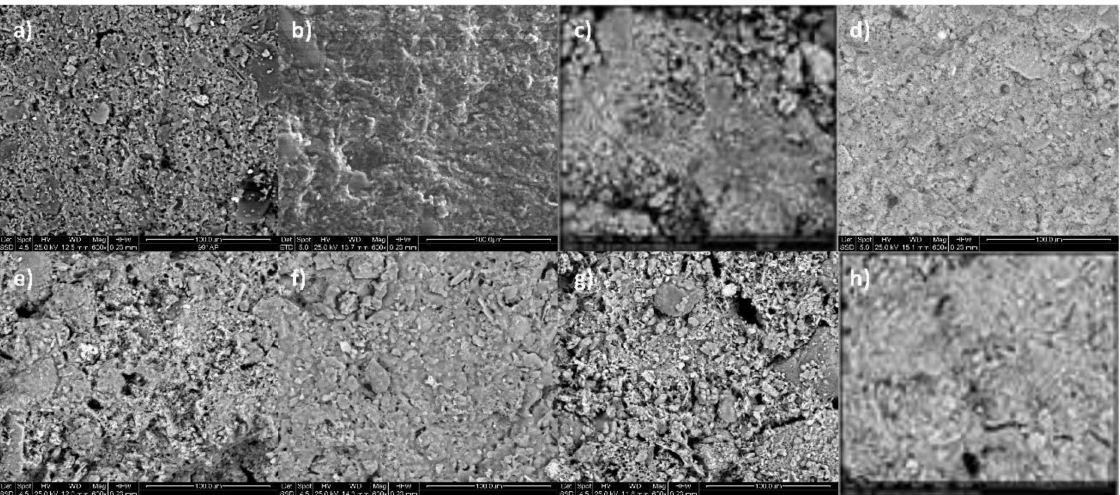
Figure 3. LWAs—SEM micrographs (600 × ) of ( a ) WBC, ( b ) RC, ( c ) WBBS 15 , ( d ) RCBS 15 , ( e ) WB FG , ( f ) RC FG , ( g ) WB CBA , and ( h ) RC CBA fired at 1000 ◦